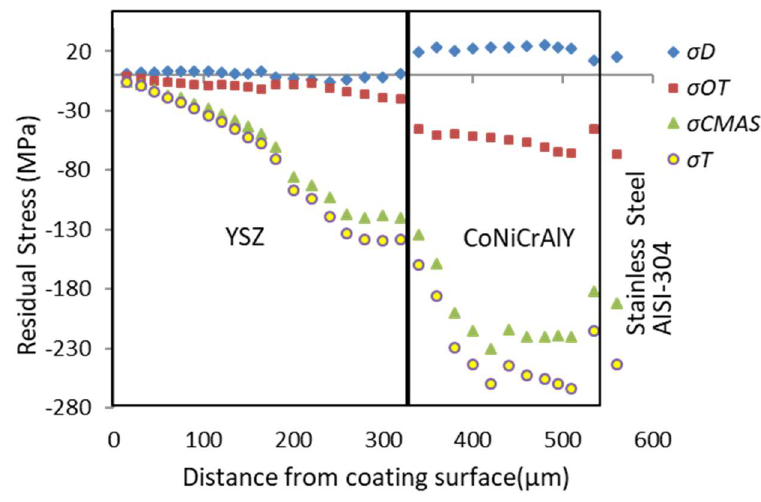
Figure 8. Total residual stress in TBC.